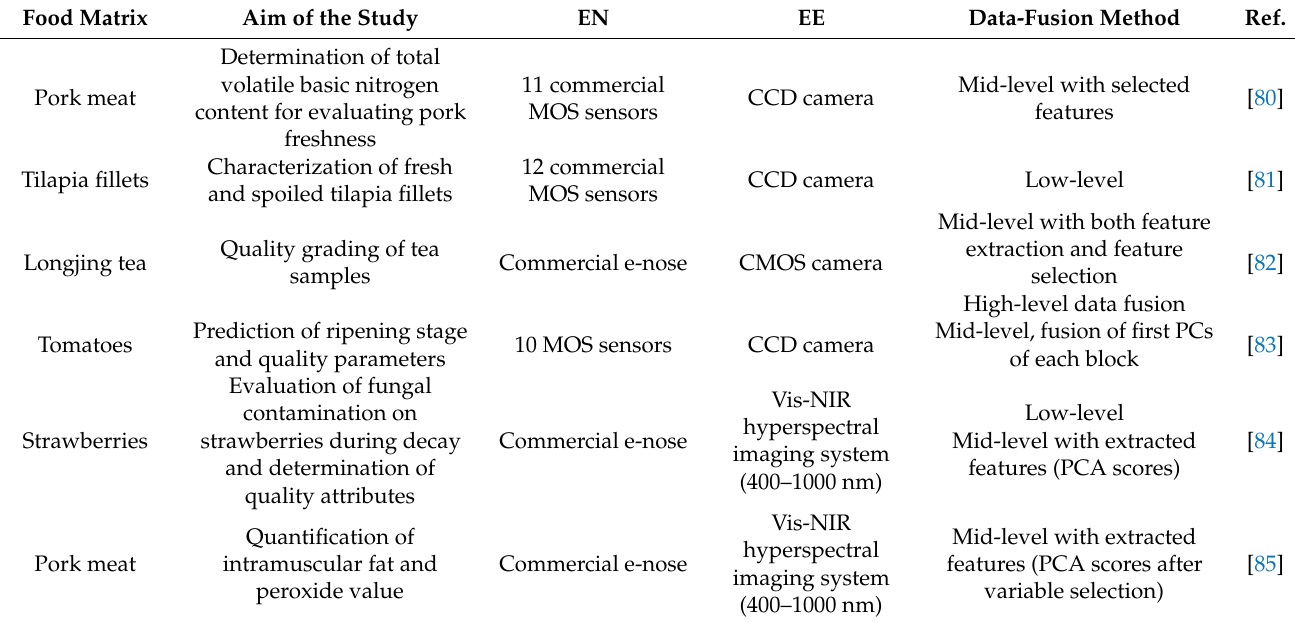
Table 3. List of publications related to the application of combined EN and EE.